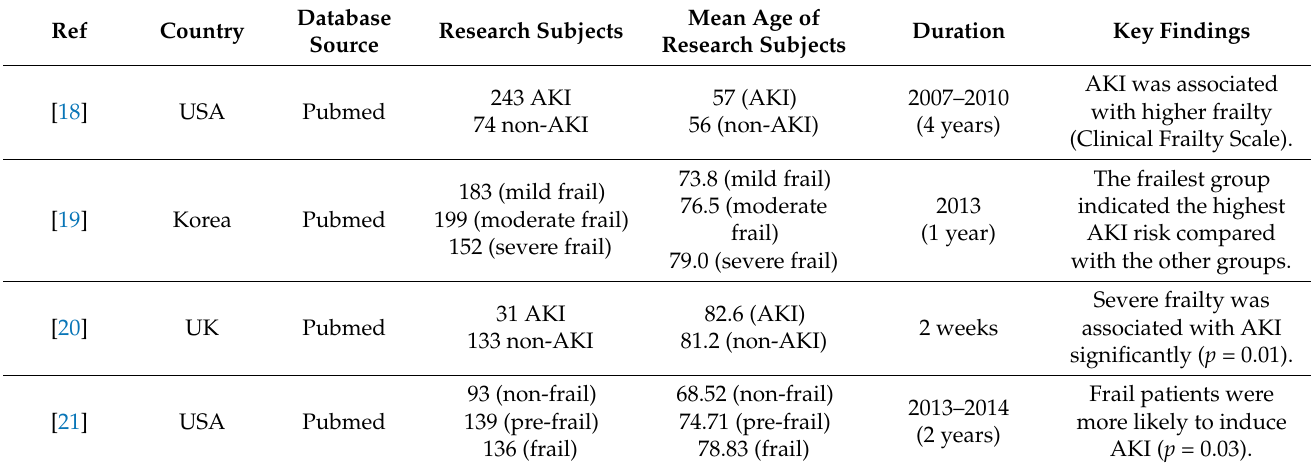
Table 1. Summary of the four studies that are referred